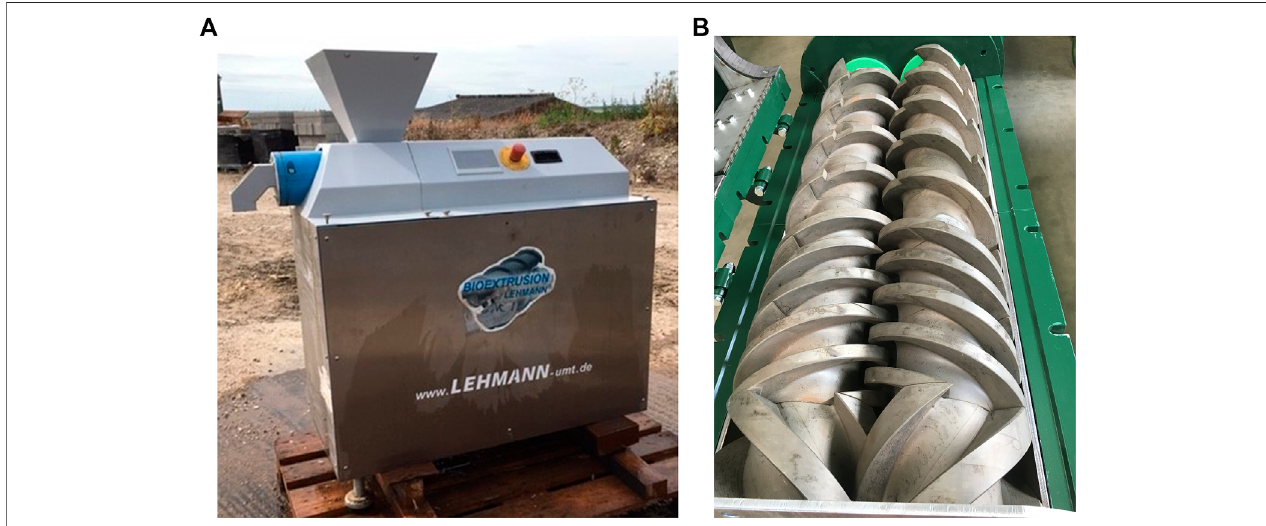
FIGURE1| Apictureofthe (A) Themini3kW/hBioExtruder, (B) thecounterrotatingdual-screwaugerfromacommercialscaleBioExtruder(modelnumberMSZB 110e).